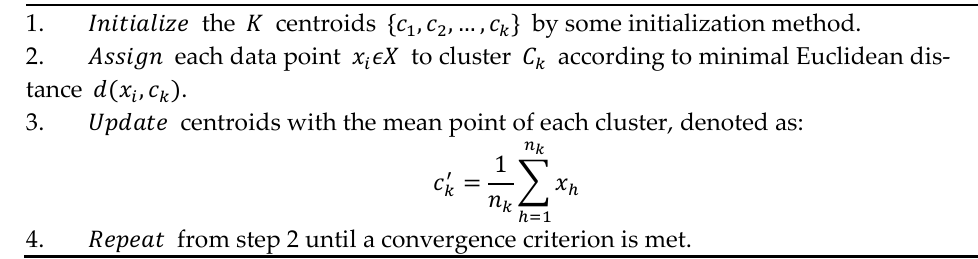
Figure 1. Sequential operation of K-Means.